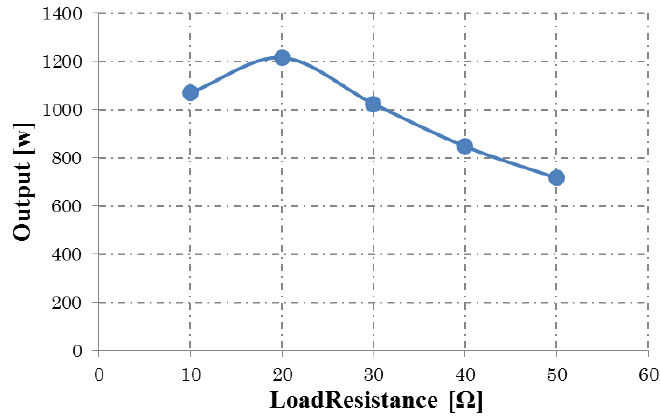
Figure 13. Output characteristics (triangular wave